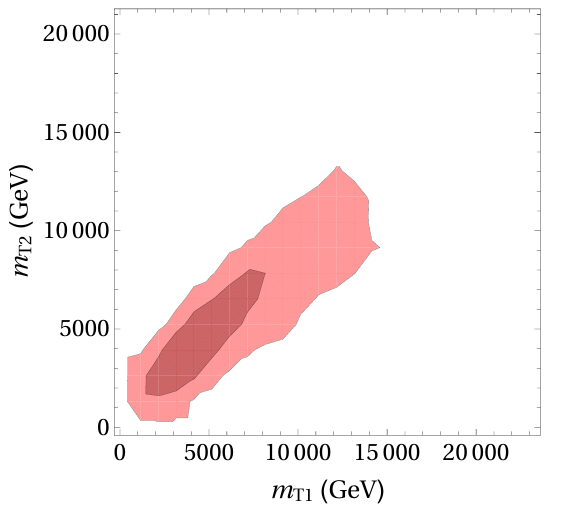
Figure 4 . Correlation between the soft mass parameters m T 1 and m T 2 de(cid:12)ned in eq. (3.12). The dark and the light red regions represent the 1 (cid:27) and the 2 (cid:27) HPD regions of the MCMC analysis,